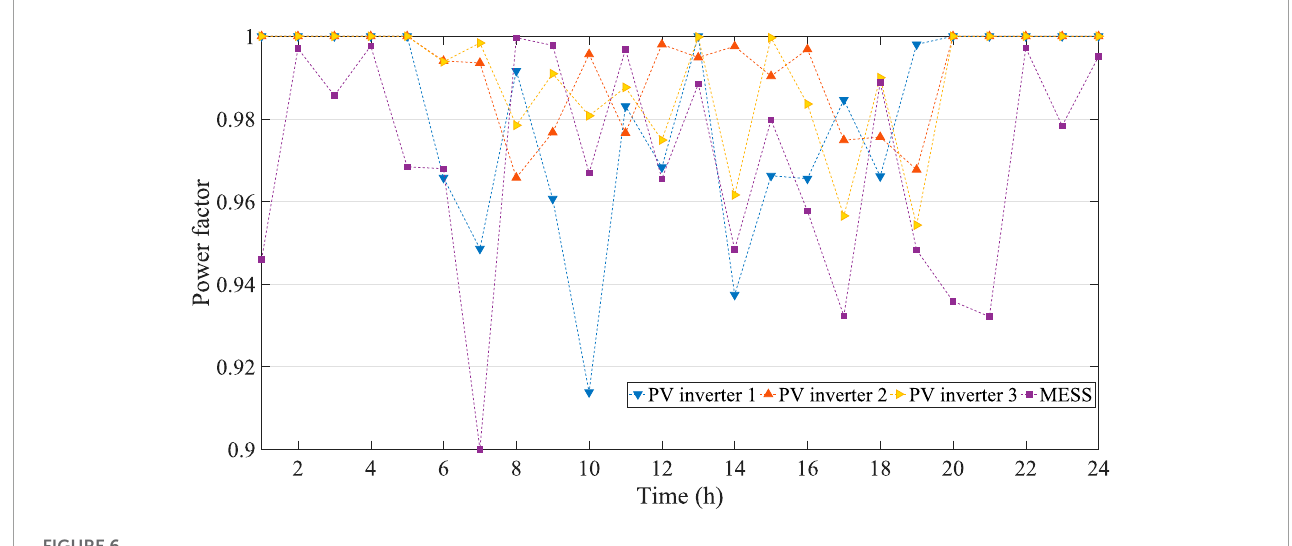
FIGURE 6 The power factor of PV inverter and MESS over 24-h.